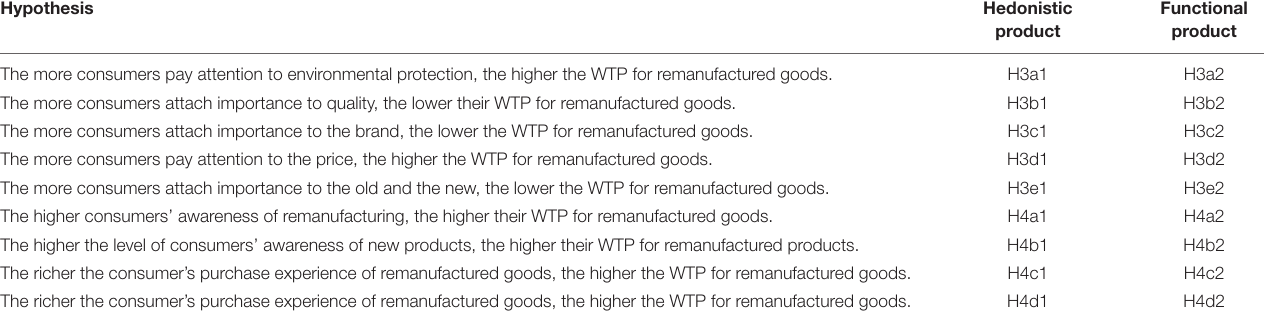
TABLE 2 | Hypothesis of consumers’